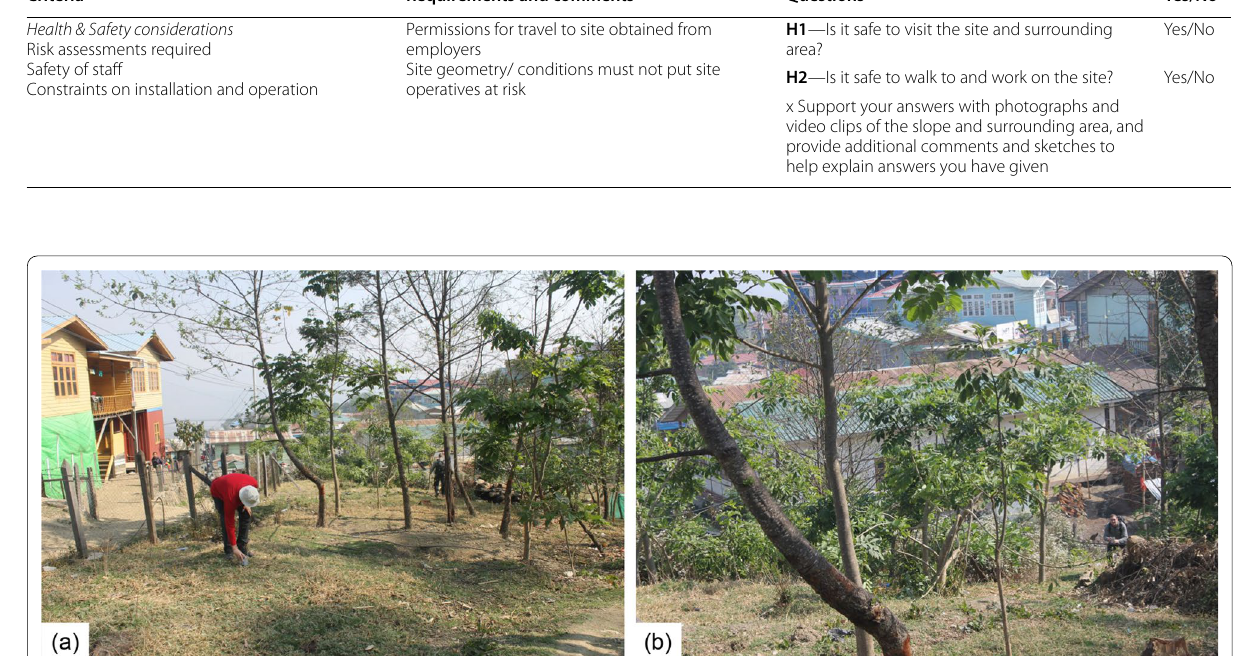
Fig. 4 General views of the slope at Keisi-Titawwin a the middle part of the slope and b the lower part of the slope